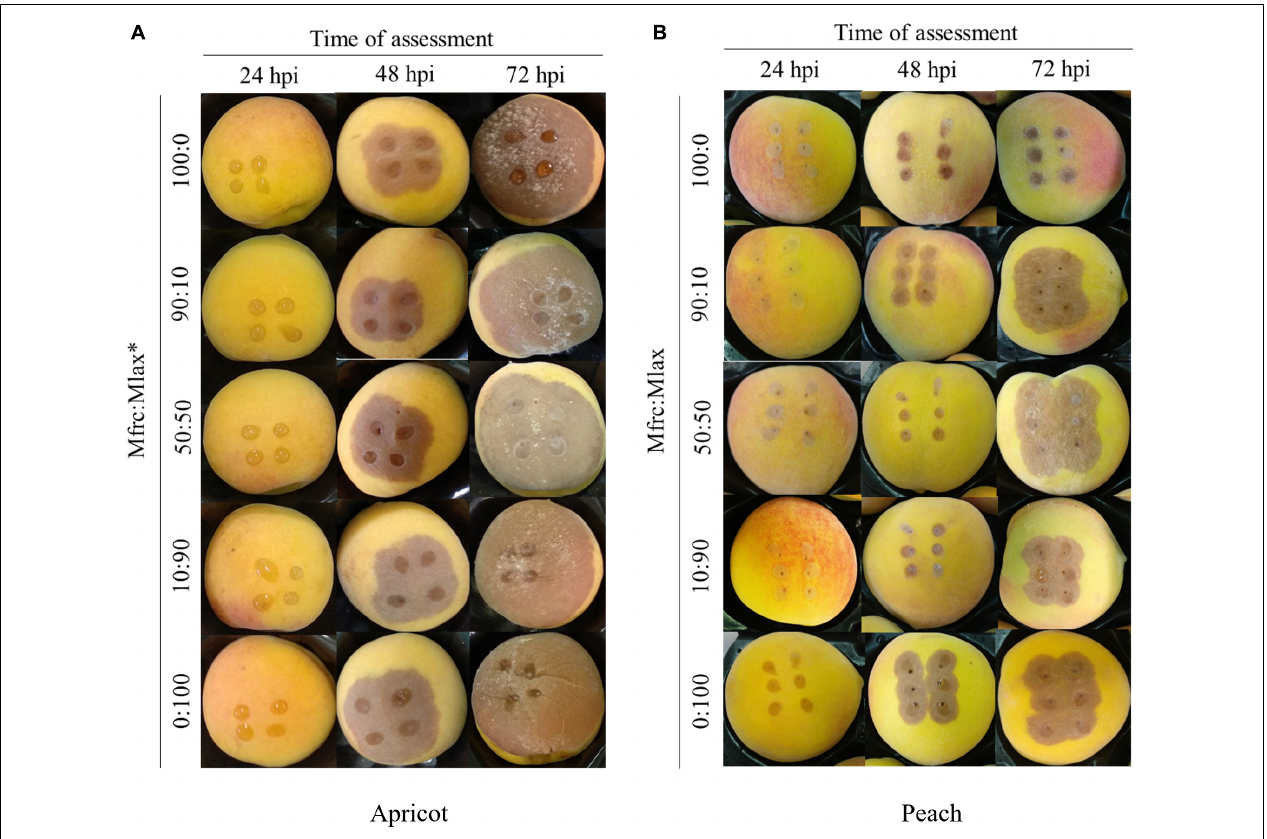
FIGURE 3 | Apricot (A) and peach (B) fruits artificially inoculated with different Monilinia fructicola (Mfrc) and M. laxa (Mlax) conidial suspension ratios